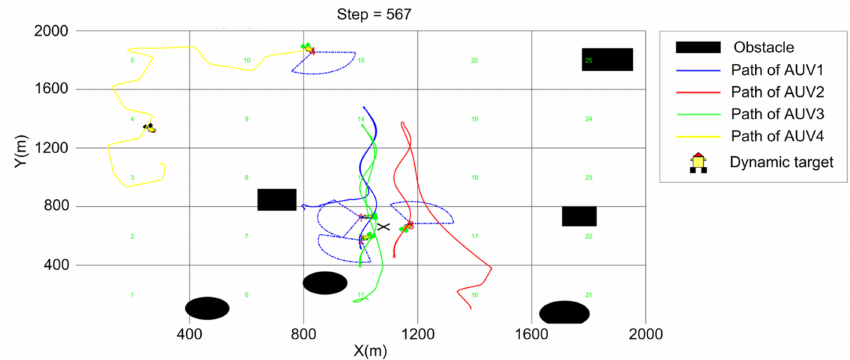
Figure 19. T = 567